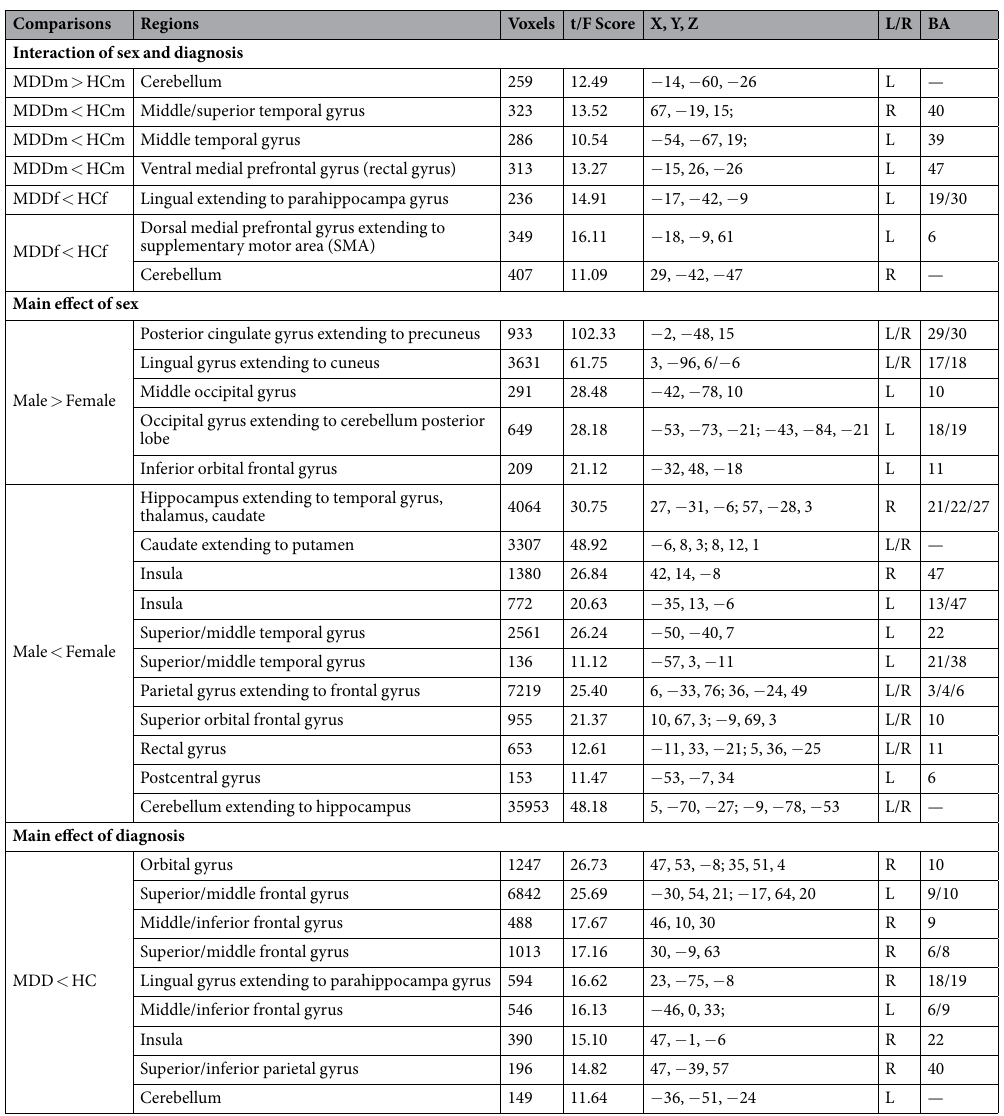
Table 2. Sex and diagnosis effects on voxel-wise GMV characteristics. All clusters were identified using the threshold of p < 0.005 AlphaSim corrected (i.e., p < 0.005 combined with a minimal cluster size of 132 voxels). All clusters were identified using post hoc two-sample t-tests within masks from F -contrasts (interaction or main effects). GMV: gray matter volume. L, left; R, right; BA, Brodman